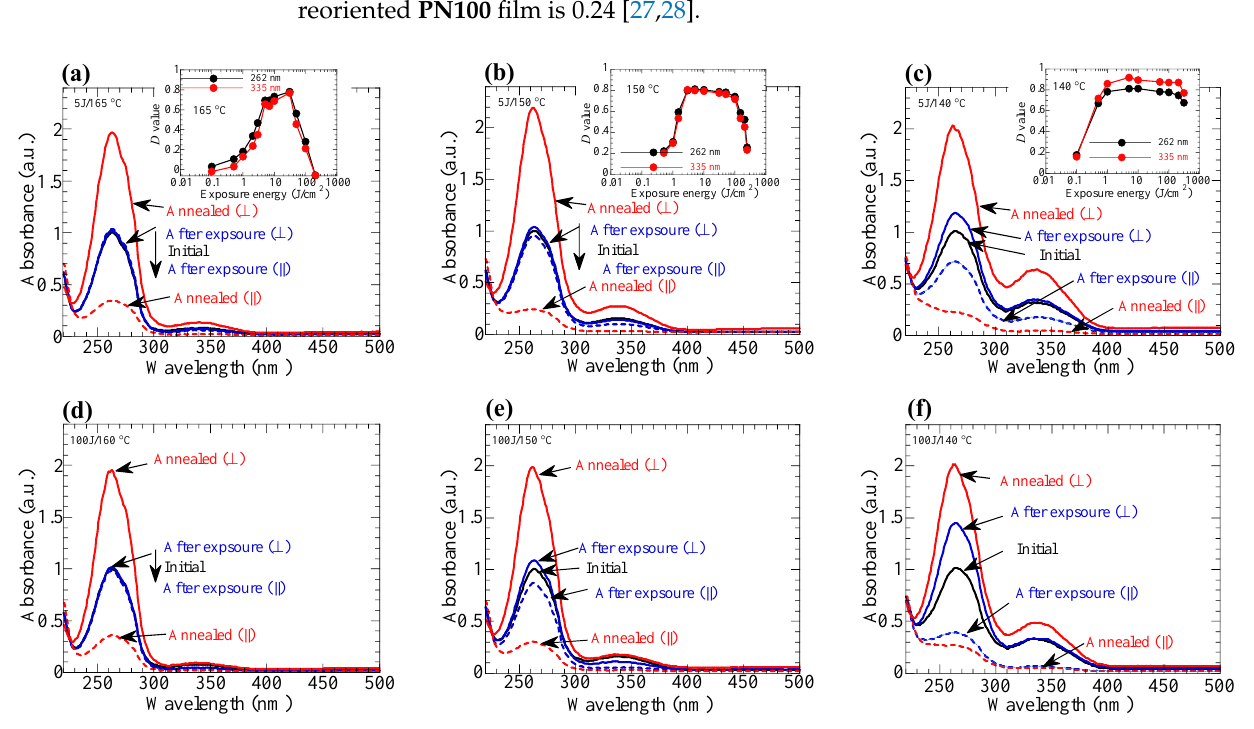
Figure 4. Changes in the polarized absorption spectra of the copolymer films before (black line) and after exposure (blue lines) to LP 365-nm light for ( a – c ) 5 J/cm 2 and ( d – f ) 100 J/cm 2 , and subsequent annealing (red lines) at ( a ) 165 °C ( PN10 ), ( d ) 160 °C ( PN10 ), ( b , e ) 150 °C ( PN20 ), ( c , f ) 140 °C ( PN50 ). Inset plot changes in the D values as functions of exposure energy.